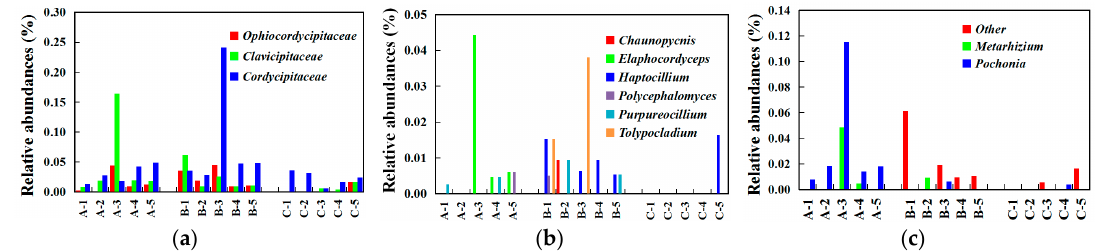
Figure 7. Relative abundance of Cordyceps -related fungi in different sampling groups: ( a ) Cordyceps -related families, ( b ) Ophiocordycipitaceae family, and ( c ) Clavicipitaceae family.